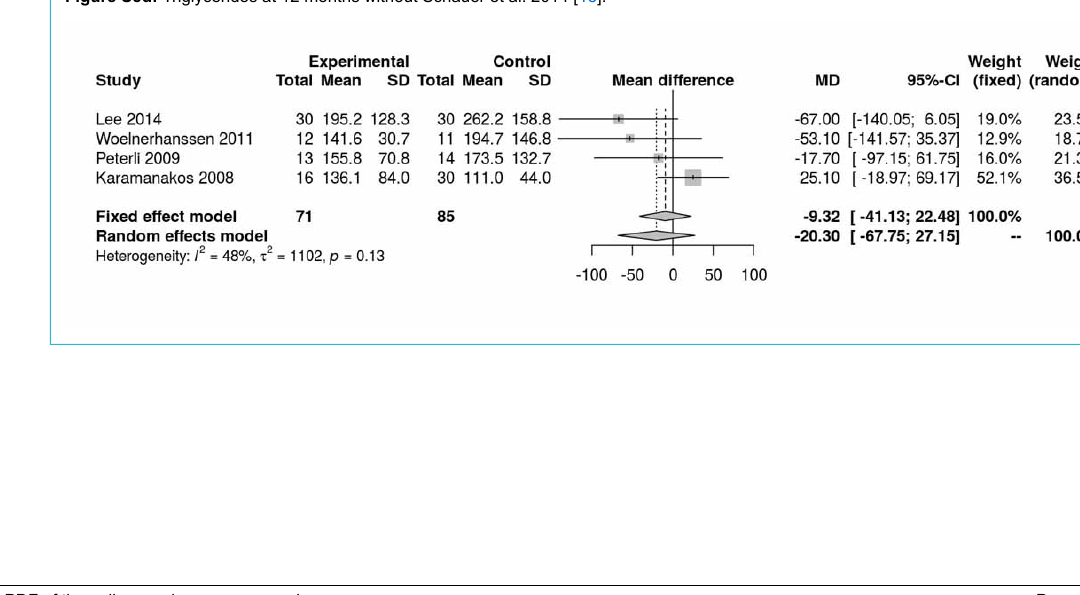
Figure S5d: Triglycerides at 12 months without Schauer et al. 2014